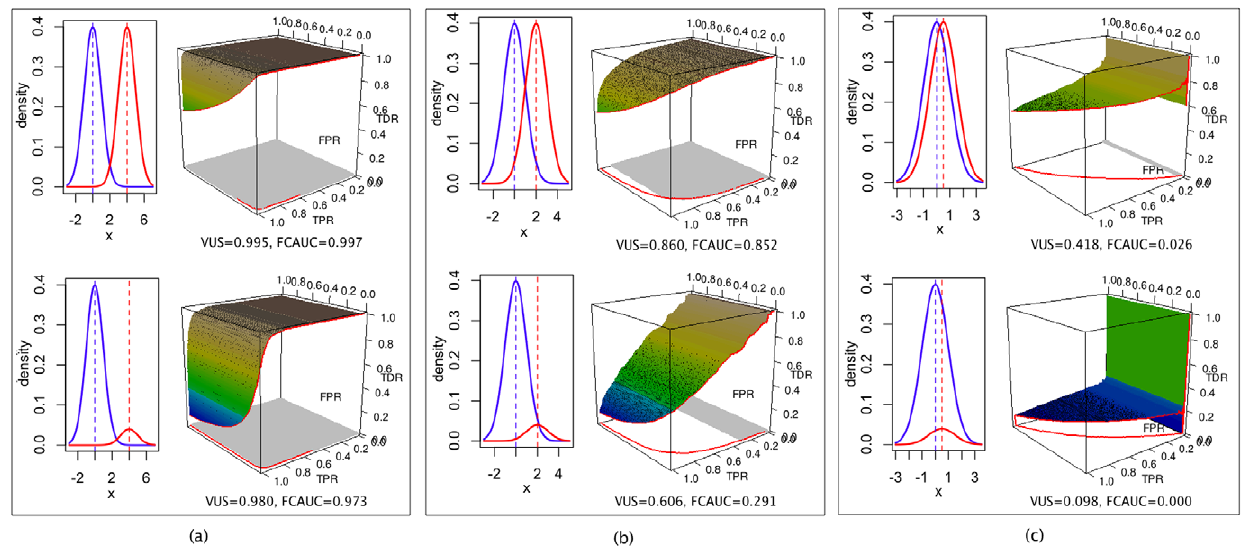
Figure 2. Illustration of the ROCS under different scenarios. Within each box, the ROCS plot (right) was generated from 10000 random samples drawn from the two Gaussian distributions (left). Upper panel: class ratio negative:positive=1:1; lower panel: class ratio negative:positive=10:1. (a) Two well-separated distributions; (b) two moderately separated distributions; (c) two severely overlapping distributions. Blue: true negative class; red: true positive class. Shaded area in the TPR-FPR plain: region under the ROC curve corresponding to FDR equal to or lower than 0.2.